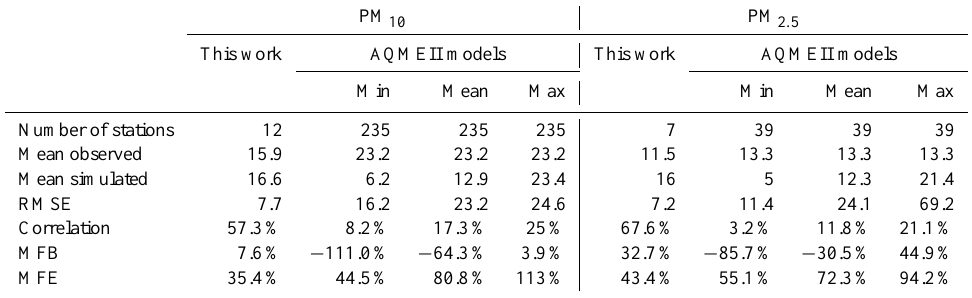
Table A1. Comparisons to observations for surface PM 10 and PM 2 . 5 over Europe (concentrations and RMSE are inµgm − 3 ) from 7 July to 31 August for this simulation (2000–2008) and the AQMEII models (2006) (Sartelet et al., 2012).